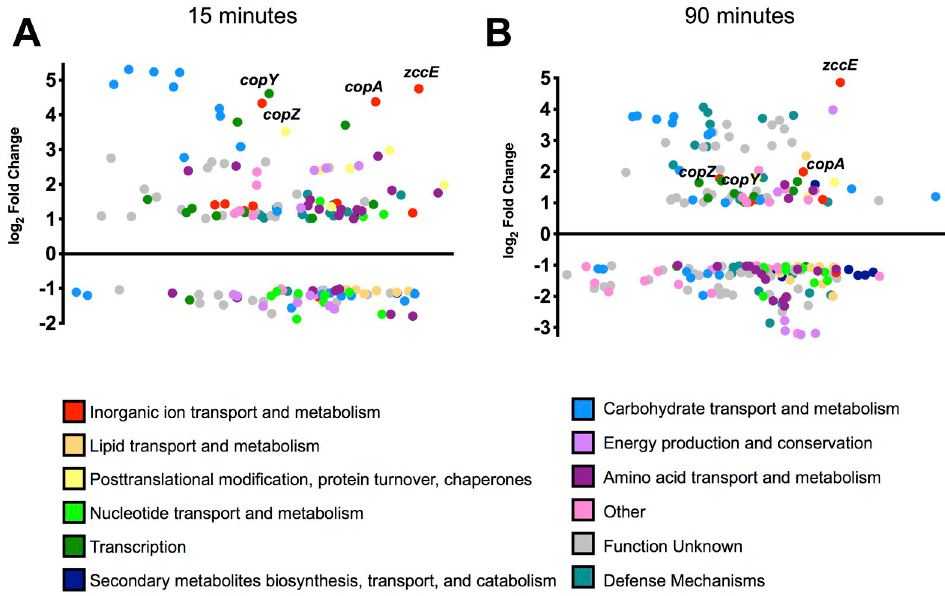
Fig 2. Summary of RNA-Seq analysis of S . mutans UA159 treated with 4 mM ZnSO 4 for 15 (A) or 90 (B) minutes compared to untreated control. The y-axis indicates the log 2 fold change in expression compared to the control, while the x-axis separates genes according to their average expression levels as compared to all other genes. The identities of selected genes of interest are indicated. The differentially expressed genes from both time points were grouped according to Clusters of Orthologous Groups (COG) functional categories